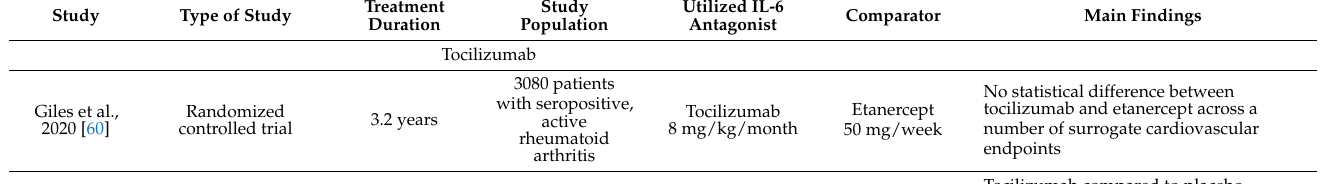
Table 2. Overview of randomized controlled trials assessing the cardiovascular effects of IL-6